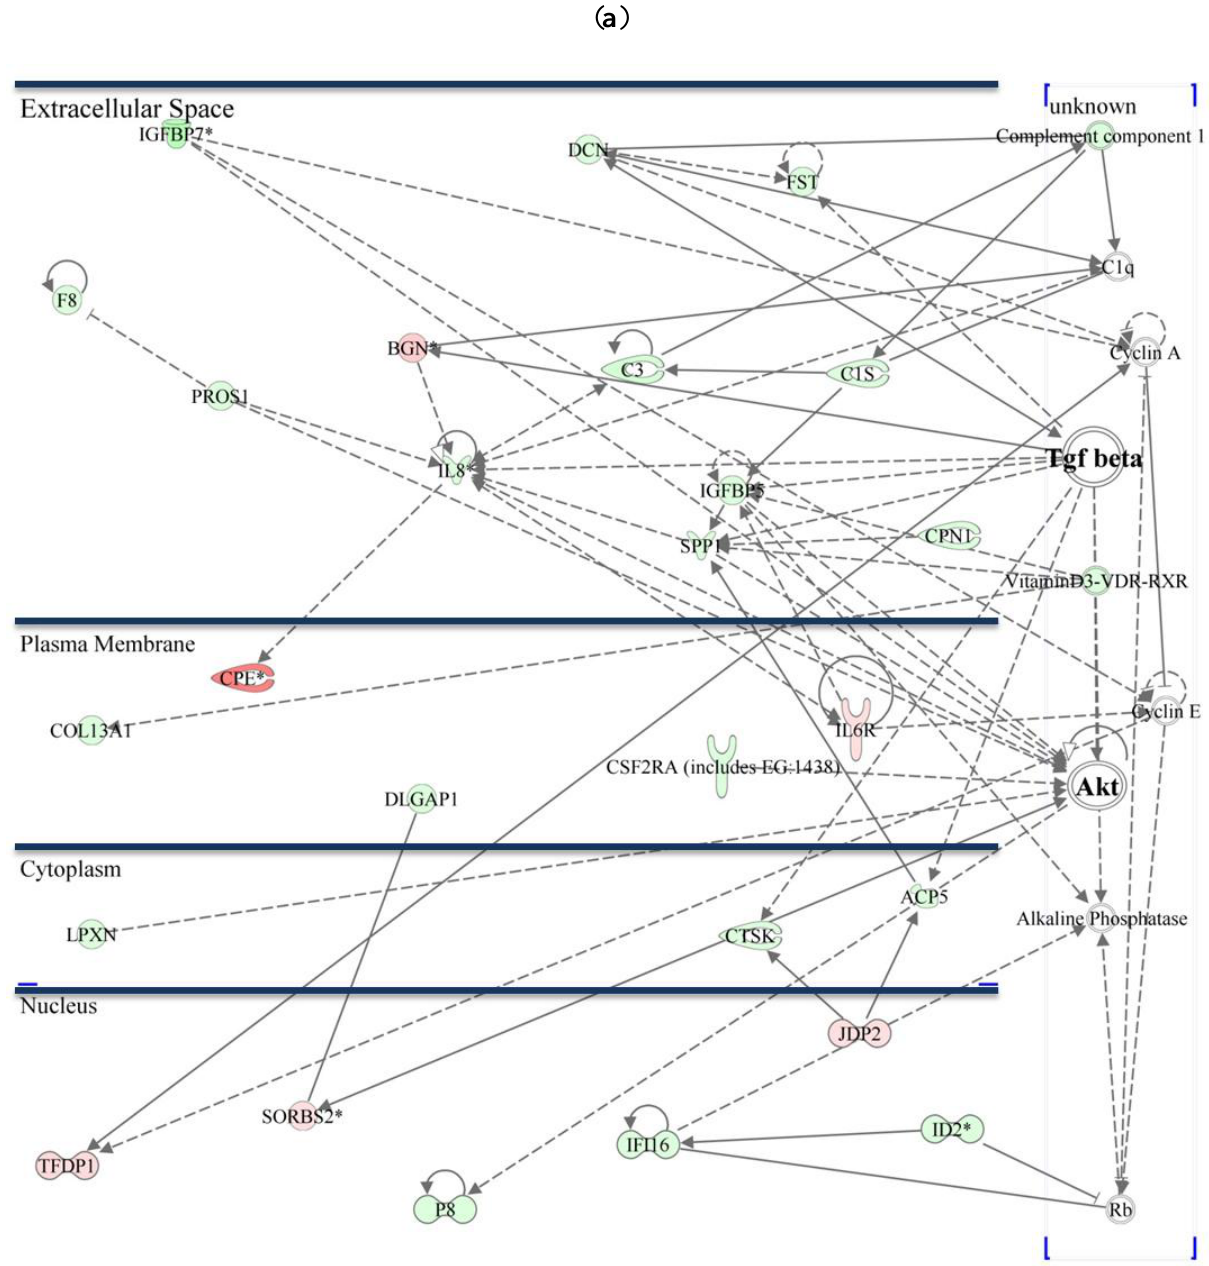
Figure 4. The AKT/TGF-  pathway and subcellular localization of differentially regulated genes connected with this signaling network: Within the AKT/TGF-  signaling pathway a total of 26 genes were differentially expressed in Group 1 ( a ); whereas 21 genes were shown to be regulated in Group 2 ( b ). ( Green marks indicate upregulation, red marks down-regulation of the respective mRNA in 229R